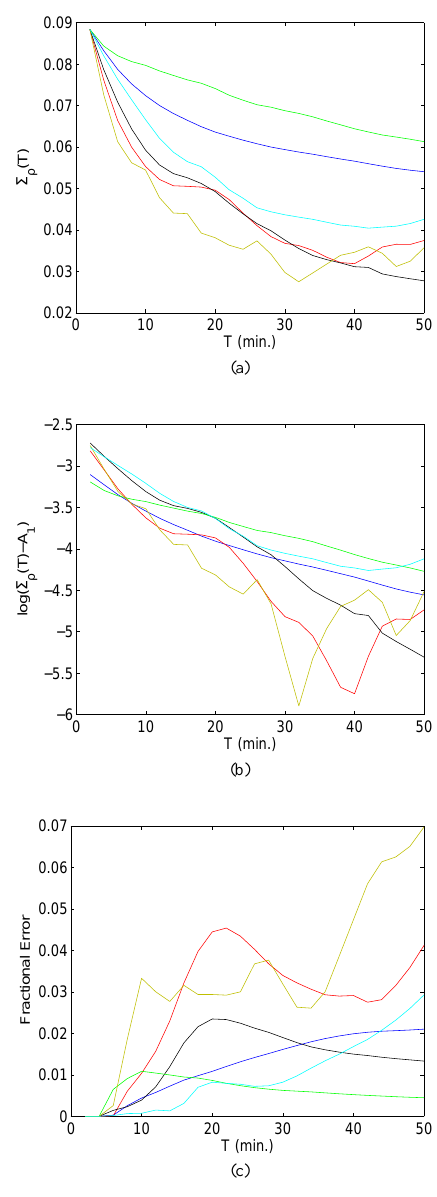
Fig. 3. Concentration variance Σ ρ ( t,t 0 ) (a), log(Σ ρ ( t,t 0 ) − A 1 ) (b), and relative error (c) plotted versus integration time T for the 6 mixing boxes with trajectories seeded at t 0 = 400 min. Other initial times give similar decay structure but different quantitative details.